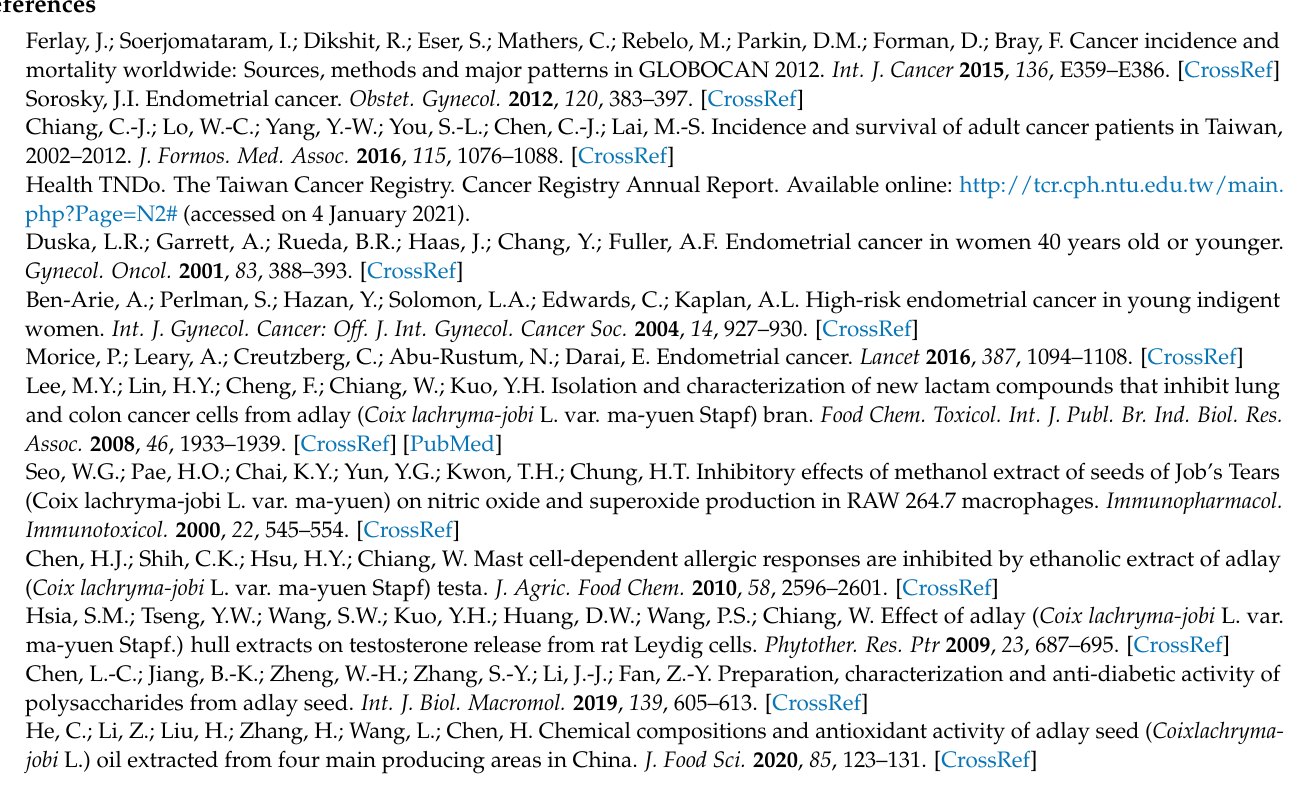
Figure S2. Chromatogram of a phenolic compounds (A) and ethyl acetate fraction of the adlay extract (ATE-EA) monitored at 320 nm. 1: protocatechnic acid. 2: ρ -hydroxybenzoic acid. 3: chlorogenic acid. 4: vanillic acid. 5: ρ -hydroxybenzaldehyde. 6: syringic acid. 7: vanillin. 8: syringaldehyde. 9: caffeic acid. 10: p -coumaric acid. 11: ferulic acid. Figure S3. Peaks were identified from the retention times of standard compounds (A) and ethyl acetate fraction of the adlay extract (ATE-EA) (B). 1, cholesterol; 2, campesterol; 3, stigmasterol; 4, β -sitosterol; 5, stigmastanol. Cholesterol was used as the internal standard. Table S1. Detection and quantification for the contents of fatty acid compounds from ATE-EA. Table S2. The retention time, regression equation and regression coefficient of the phenolic compounds. Table S3. The retention time, regression equation and regression coefficient of the flavonoid